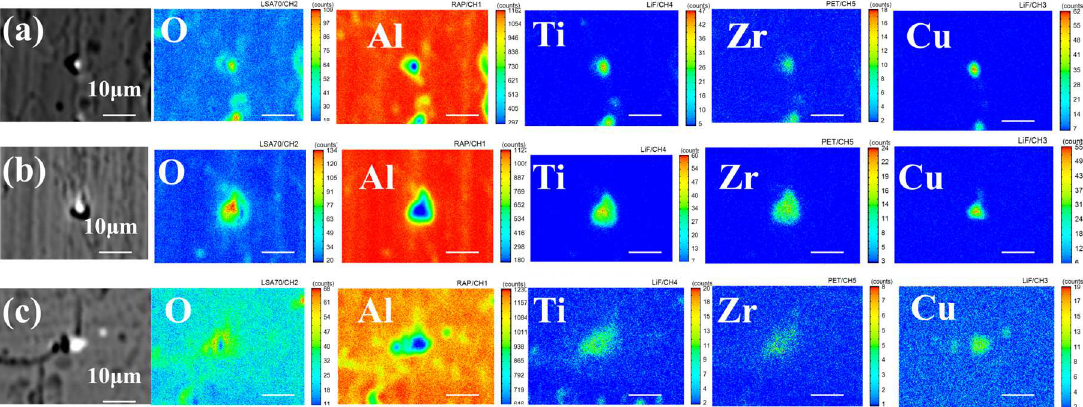
Figure 7. Results of EMPA of 6061 aluminum alloy with synchronous chemical conversion at different times: ( a ) at 100 s, ( b ) at 120 s, ( c ) at 140 s.